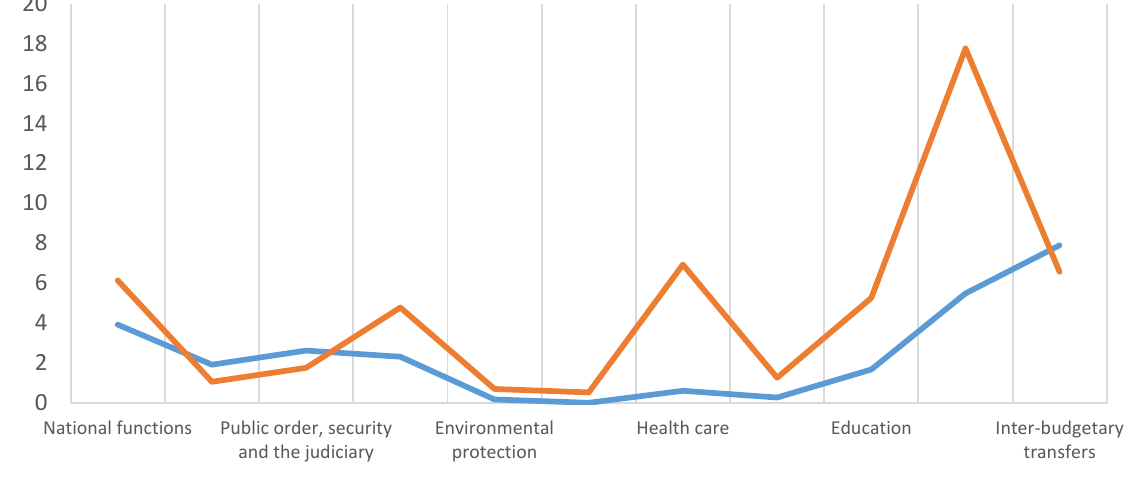
Figure 4. Average level of government